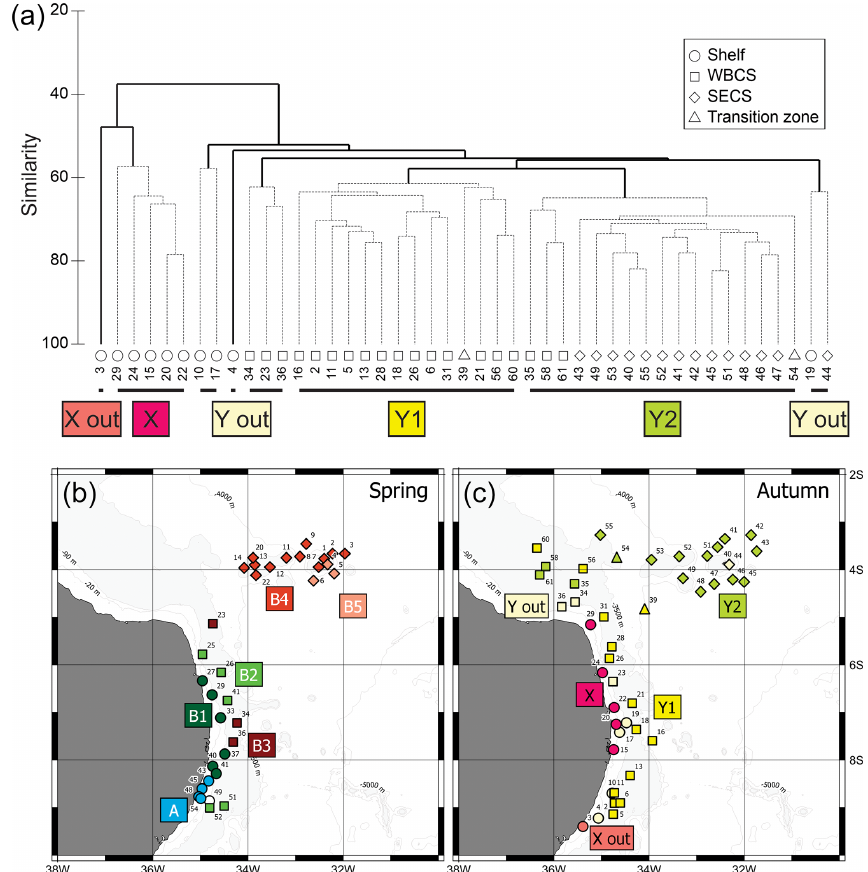
Figure 7. (a) Cluster analysis dendrogram of autumn 2017 data indicating two main groups and subgroups of stations with similar planktonic cnidarian communities in the western tropical south Atlantic Ocean; dashed lines are significant groups in the SIMPROF analysis. (b) Map indicating location of the groups and subgroups arranged in the cluster analysis during spring 2015 (Tosetto et al., 2021). (c) Map indicating location of the groups and subgroups arranged in the cluster analysis during autumn 2017. Dendogram of spring data in Tosetto et al.